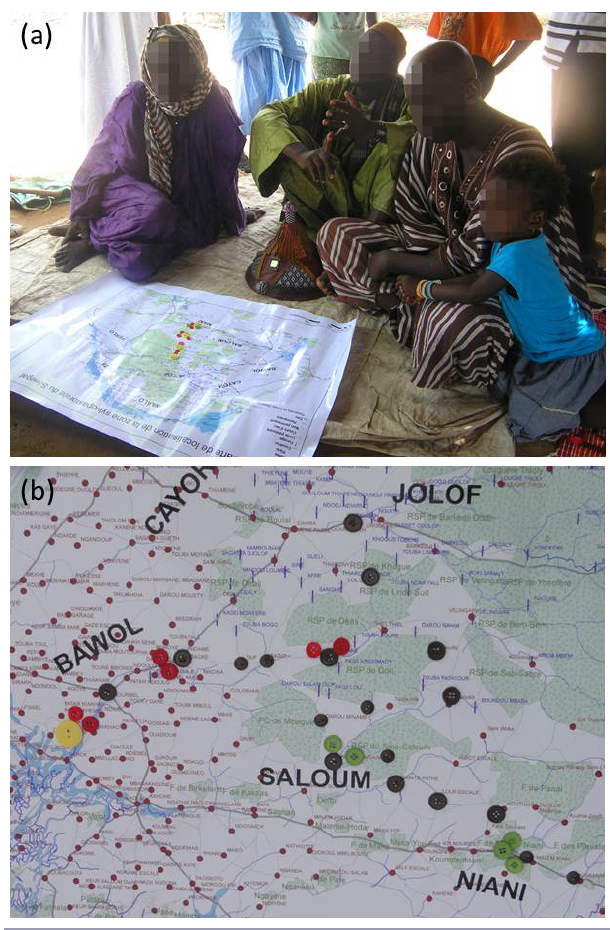
Fig. 2. Illustration of the map activity. (a) Discussion of transhumance with a group of Serer informants. (b) Buttons were used to indicate the locations of the home community (yellow), routes (dark gray), observations of vegetation degradation (red), and rehabilitation/greening (green) on the base map.